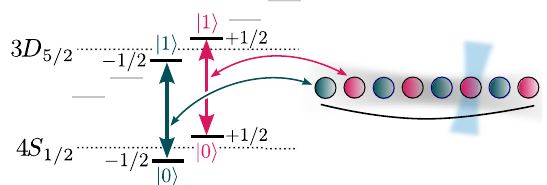
FIG. 3. Crosstalk suppression by staggered encoding of qubits in different, well-separated Zeeman transitions. For a given site k , the qubit is implemented in the j 4 S; m ¼ ð − 1 Þ k 1 = 2 i ↔ j 3 D; m ¼ ð − 1 Þ k 1 = 2 i